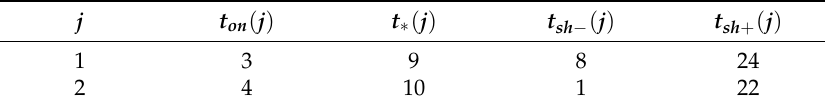
Table 2. Contract data of shiftable